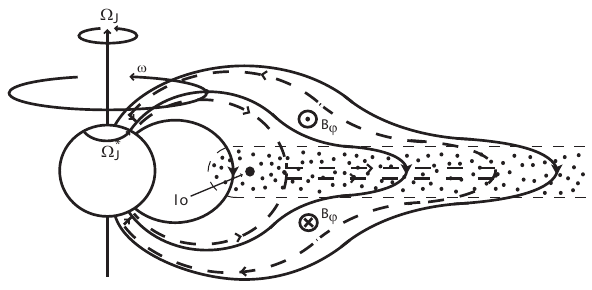
Fig. 1. Sketch of a meridian cross section through Jupiter’s inner and middle magnetosphere, showing the principal physical features involved. The arrowed solid lines indicate magnetic field lines, the arrowed dashed lines the magnetosphere-ionosphere coupling cur- rent system, and the dotted region the rotating disc of out-flowing iogenic plasma. (From Cowley and Bunce,